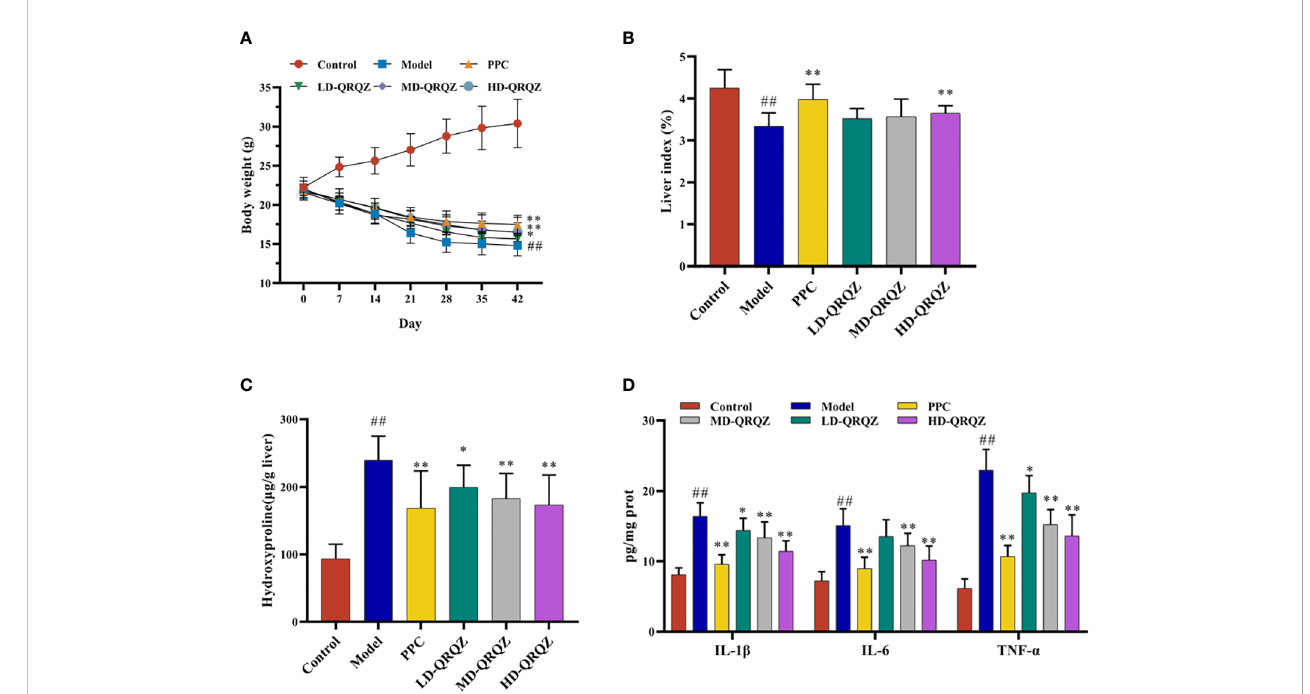
FIGURE 1 QRQZ alleviated liver injury and in fl ammation in MCD induced NASH mice. (A) Body weight change curves of each group. (B) The liver/body weight indexes of each group. (C) Hydroxyproline levels in liver of each group. (D) Serum pro-in fl ammatory cytokines of each group. Data are presented as the mean ± standard deviation. ## P < 0.01 as compared to the Control group; * P < 0.05 as compared to the Model group; ** P < 0.01 as compared to the Model